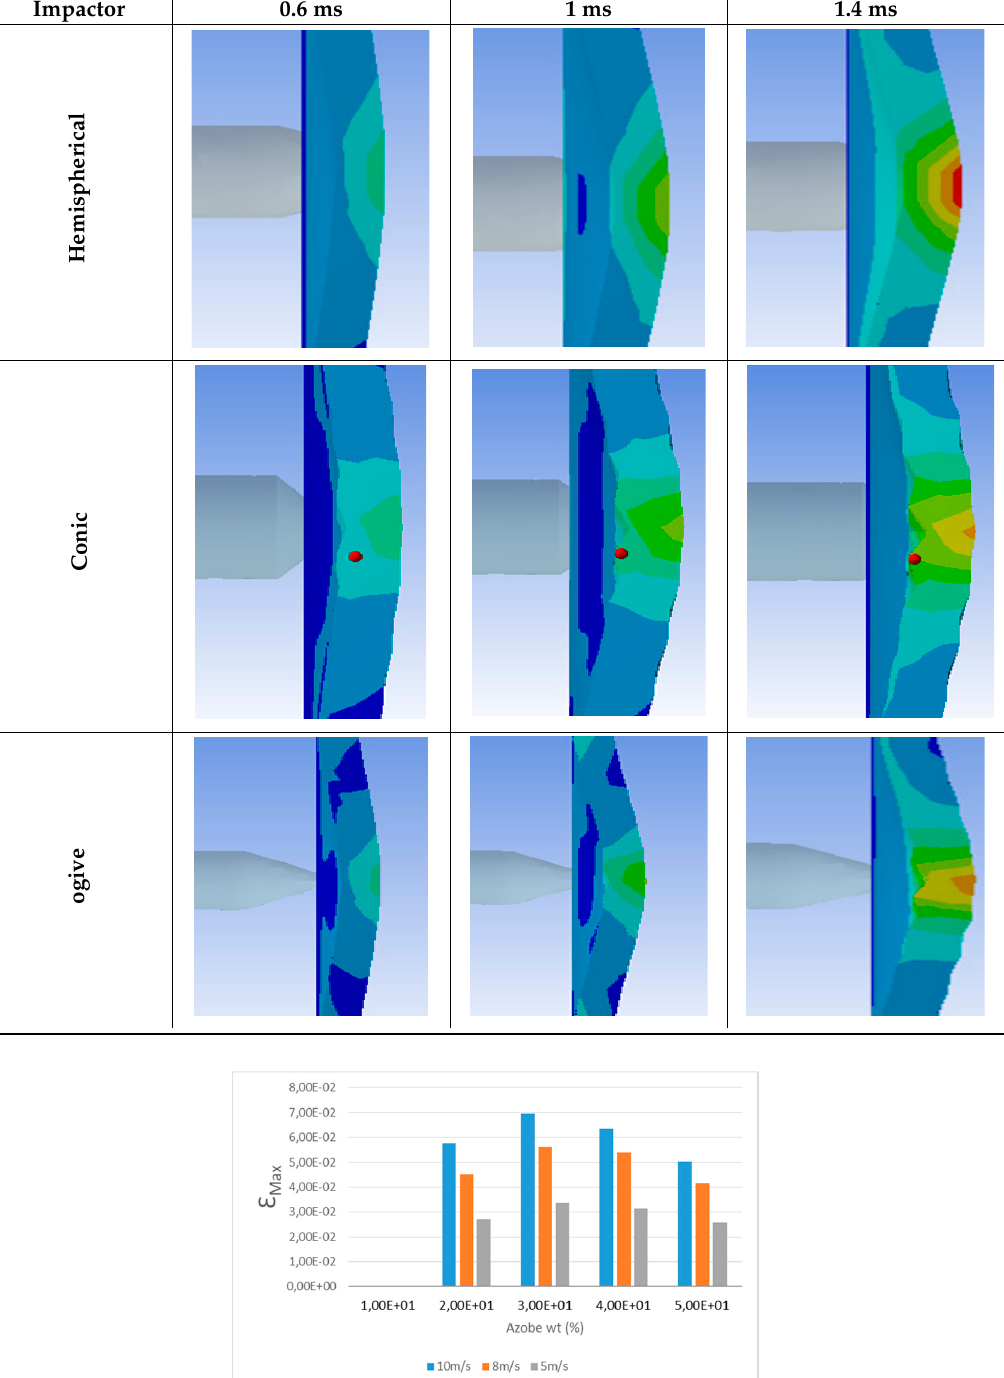
Figure 10. Maximum strains at the center of the plate.